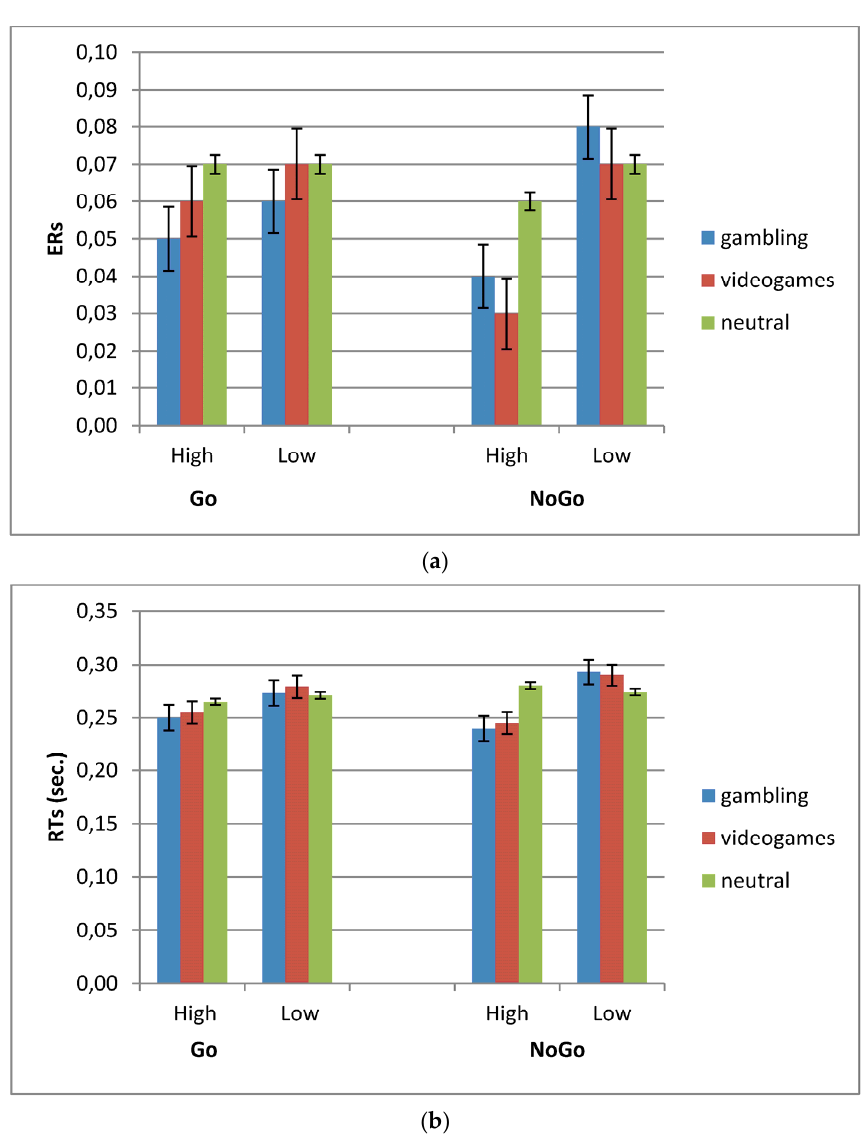
Figure 2. ( a ) ERs values as a function of stimulus type, Go/NoGo task and IAT; ( b ) RTs values as a function of stimulus type, Go/NoGo task and IAT.